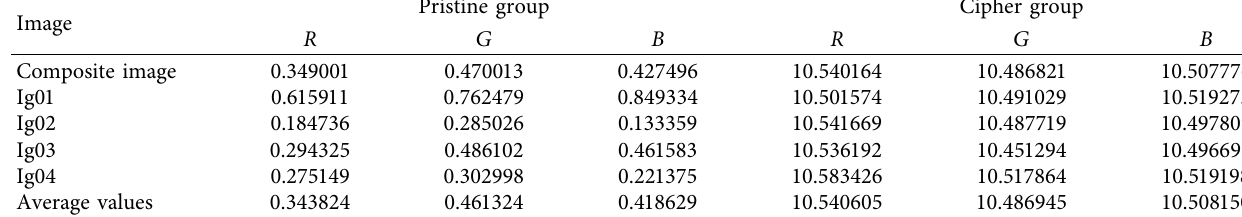
Table 5: Contrast values of the investigated dataset.